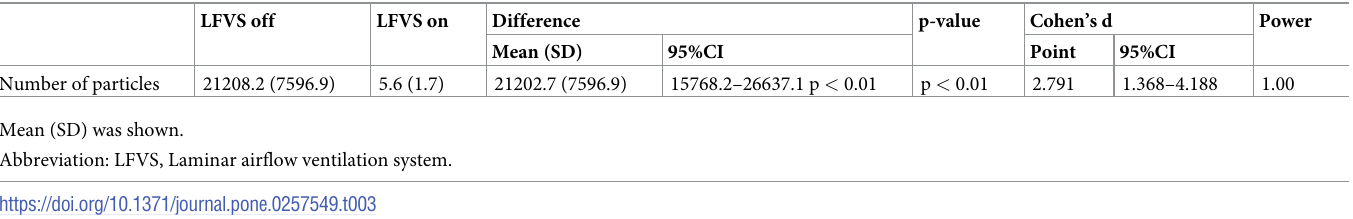
LFVS off LFVS on Difference p-value Cohen’s d Power Mean (SD) 95%CI